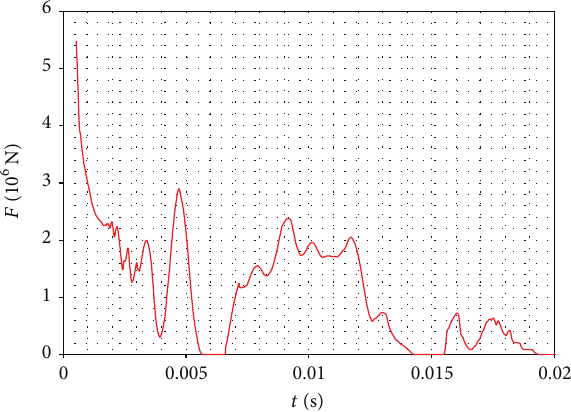
Figure 3: Impact force variation. Mass 3200 kg dropped from height 16